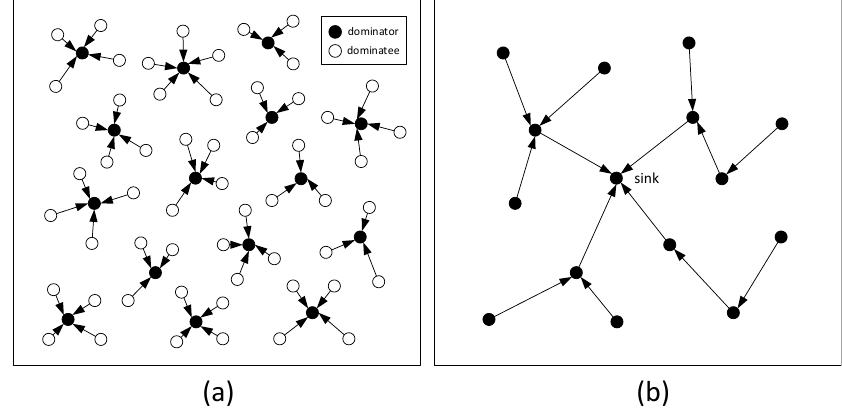
Figure 1. n -to-1 data collection method ( a ) Dominator collects data of its dominatees. ( b ) Dominator data reaches sink via multi-hop route.